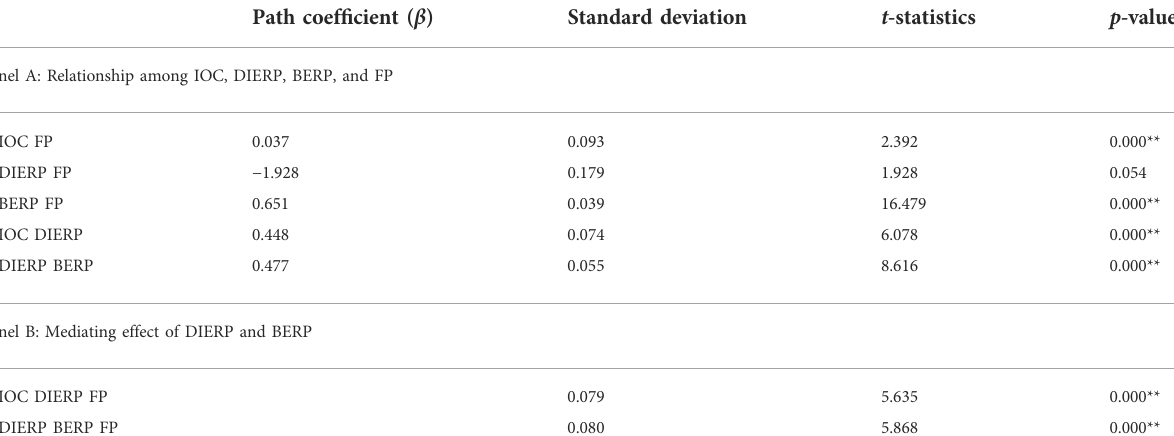
TABLE 8 Relationship among IOC, DIERP, BERP, and FP, and the mediating role of BERP and DIERP: Energy and manufacturing sector